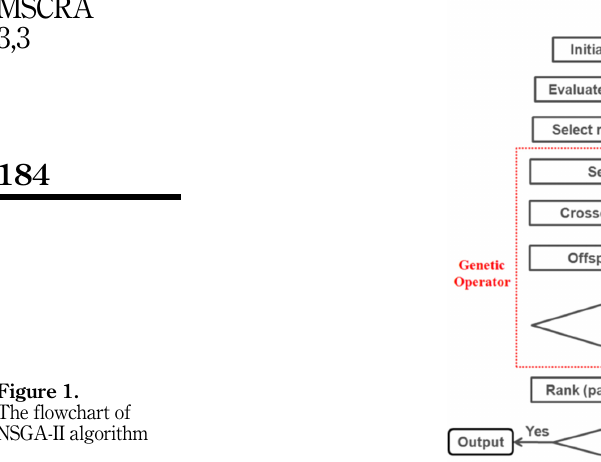
Figure 1. The flowchart of NSGA-II